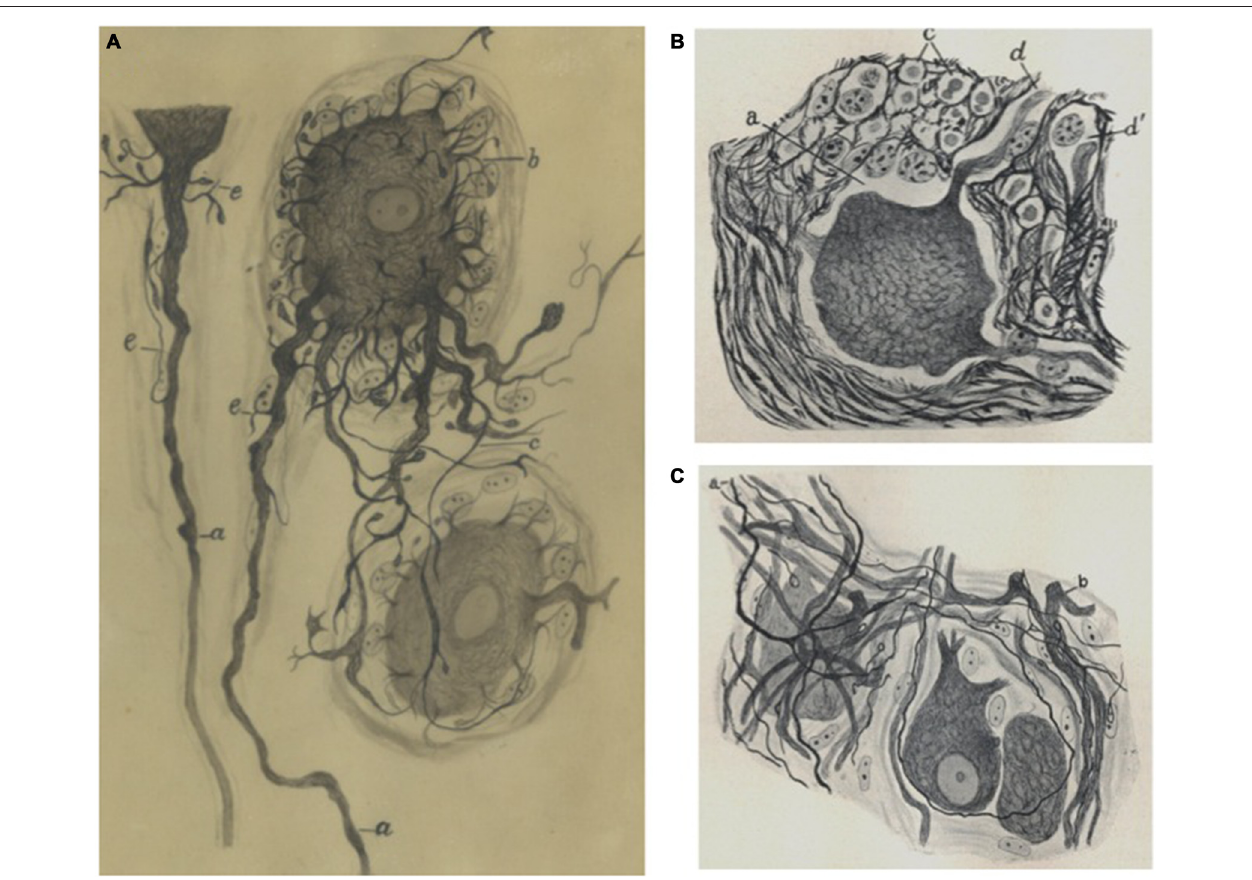
FIGURE 3 | Sympathetic neurons by Fernando de Castro. (A) de Castro’s hand-made schematic illustration of sympathetic neurons stained with the Cajal’s method, showing short long ( a –the axón arises from this dendrite at a distance from the soma, c ), short dendrites ( b ). This image was published in de Castro (1933). (B) Partial view of a sympathetic ganglion (normal condition) of an adult cow (de Castro, 1937). (C) Portion of a sympathetic ganglion with regenerated preganglionic fibers ( a ) after a vagus-sympathetic crossed anastomosis (de Castro, 1937; A) is part of Archive Fernando de